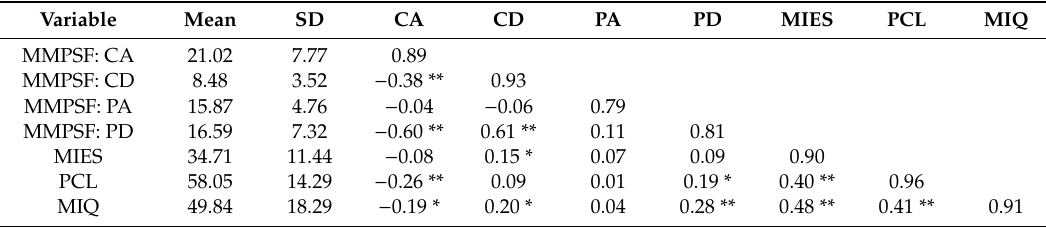
Table 1. Means, Standard Deviations and Intercorrelations for Major Variables.